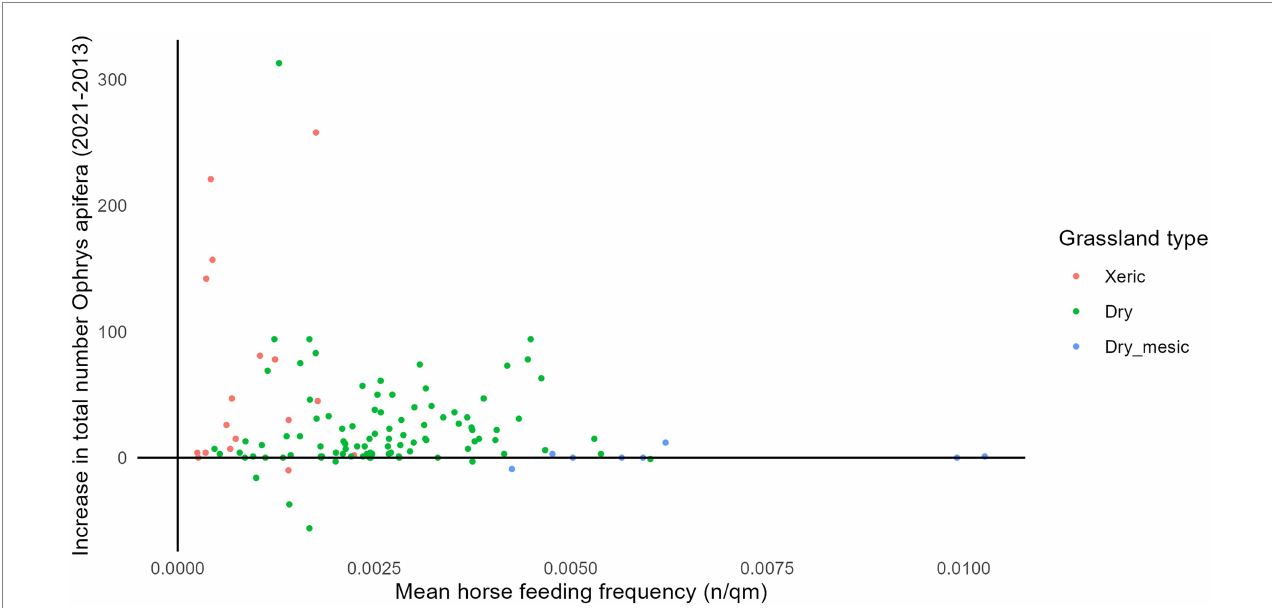
FIGURE 7 Increase in total number of Ophrys apifera from 2013 to 2021 and mean horse feeding frequency from April–March from 2011–2021 on the grid cells in the different calcareous grassland types ( n = 121; xeric n = 17, dry n = 96, dry-mesic n = 8).